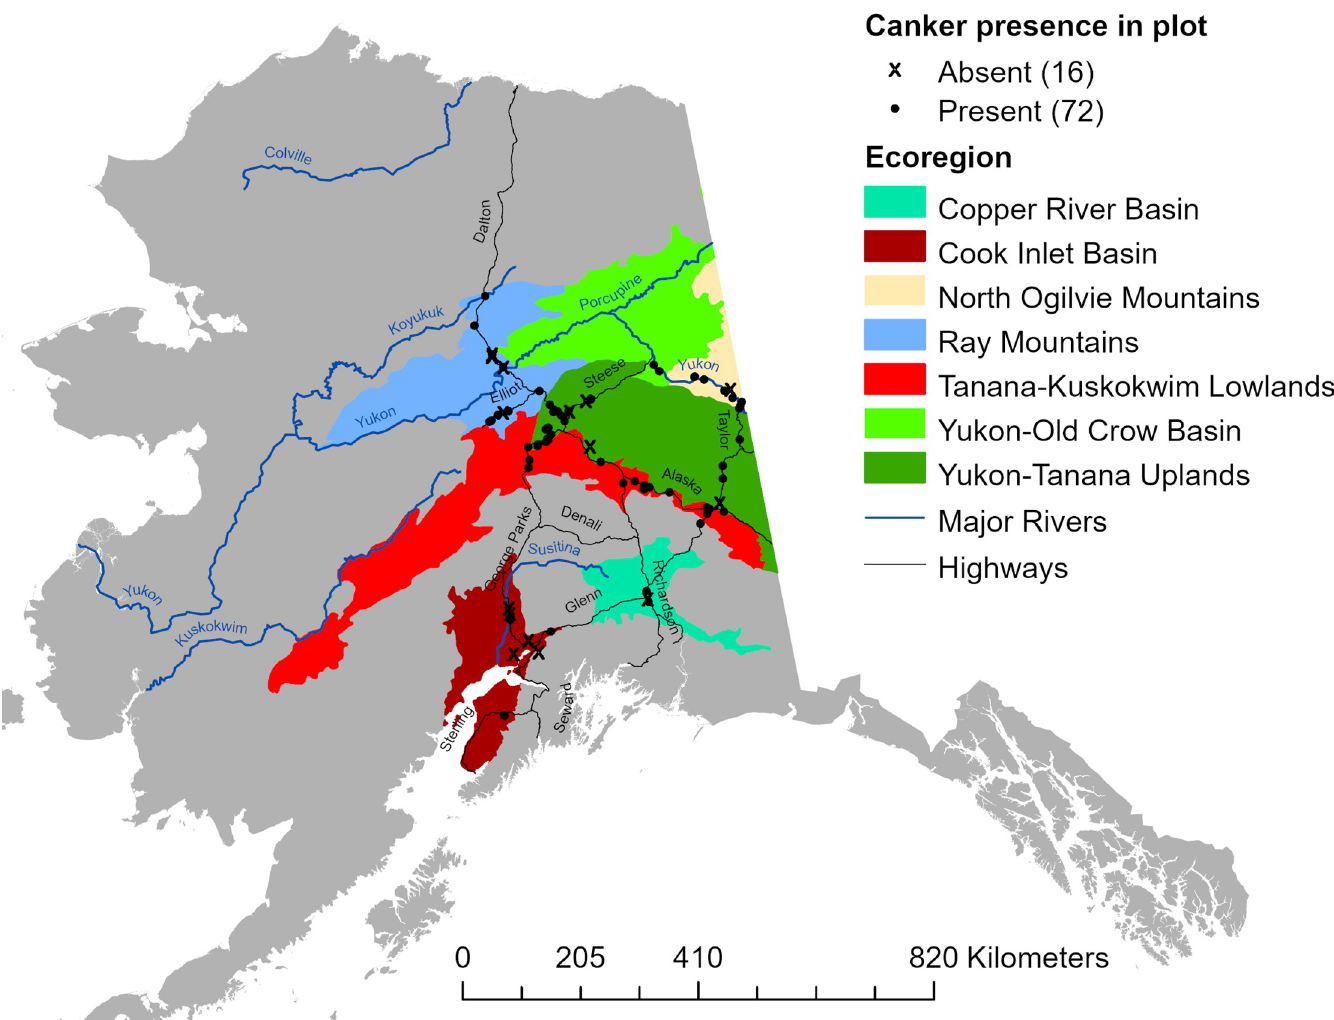
Fig 1. Map of study sites. Location of 88 sites inventoried for aspen canker. For analyses, sites within the Yukon-Old Crow Basin were grouped with those from the North Ogilvie Mountains.